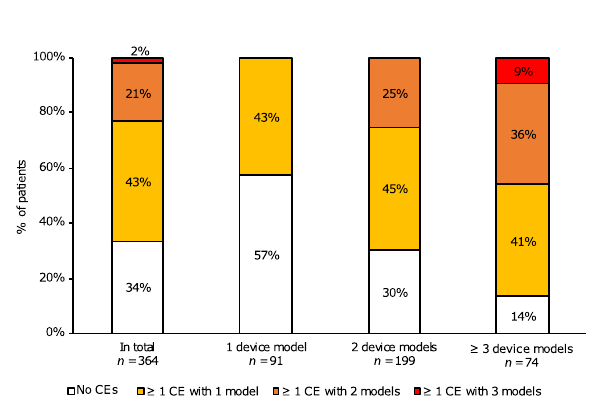
Fig. 2 Critical inhaler technique errors as percentages of COPD patients making ≥ 1 critical error with one, two or three or more device models, in total and by number of device models used. CE critical